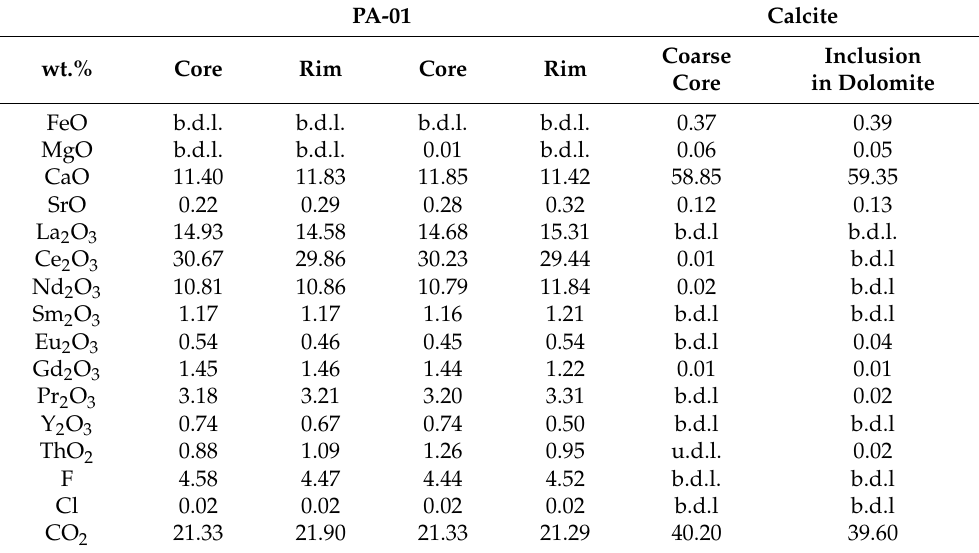
Table 2. Electron microprobe analyses of parisite sample PA 01 and calcite. CO 2 is calculated. B.d.l.: below detection